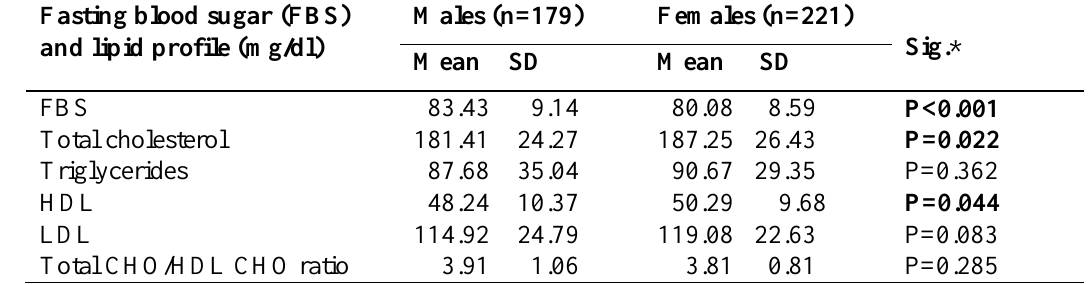
Table 2. Distribution of mean fasting blood sugar and blood lipid levels of the study population by